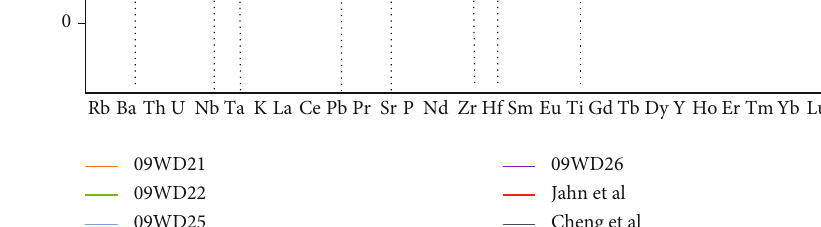
Figure 2: Cobweb diagram of trace elements normalized in the primitive